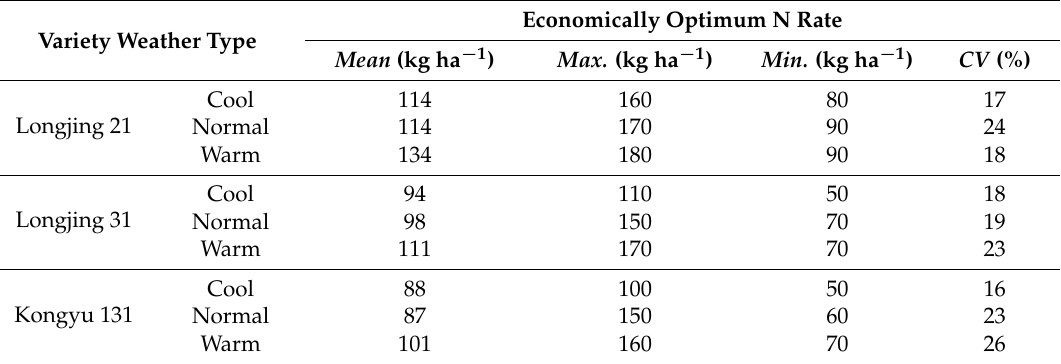
Table 5. Summary of simulated, economically-optimum N rates that maximized marginal net return for nine variety–weather combinations during